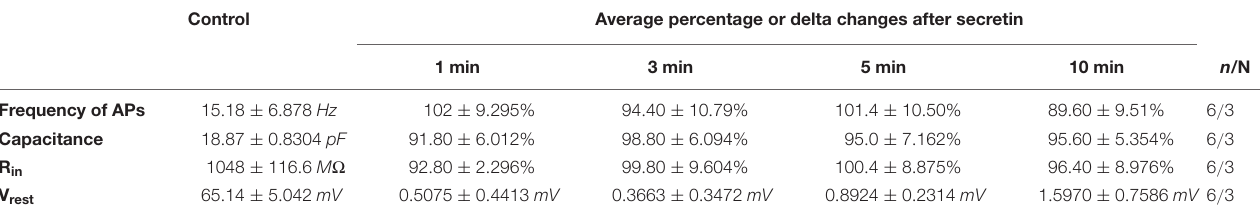
TABLE 4 | Effect of secretin on the evoked APs, the passive membrane properties and V rest in the presence of picrotoxin. Control